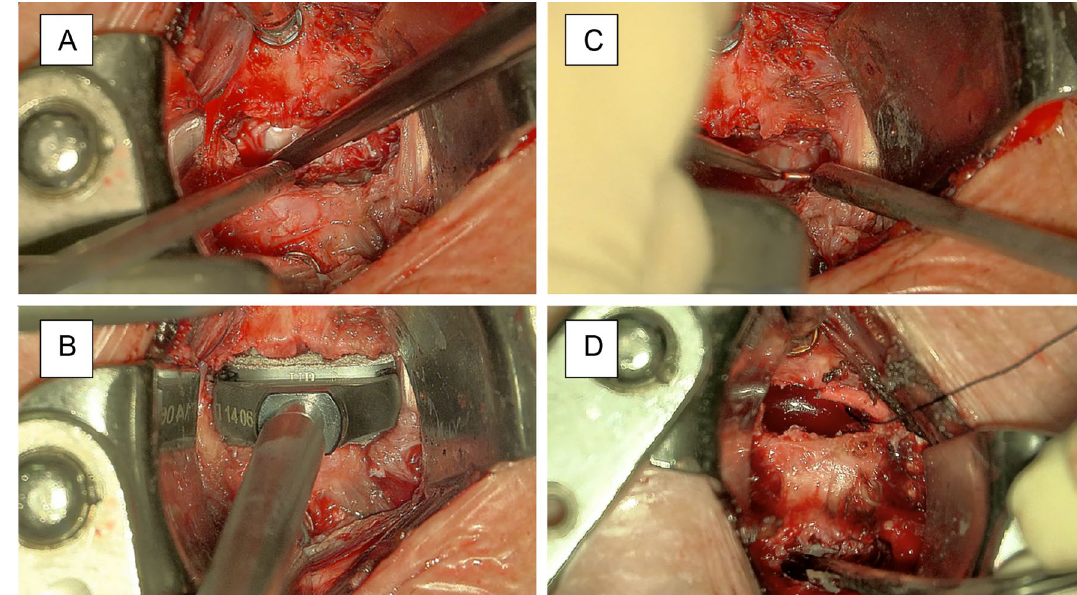
Figure 7. Exemplary case 1: anterior cervical discectomy and disc replacement or fusion. ( A ) Anterior discectomy and removal of the anterior longitudinal ligament; ( B ) Cervical disc replacement with prosthesis; ( C ) Cervical foraminotomy; ( D ) Saving two different targets of focus enables semi-automatic adjustment between the two levels of interest